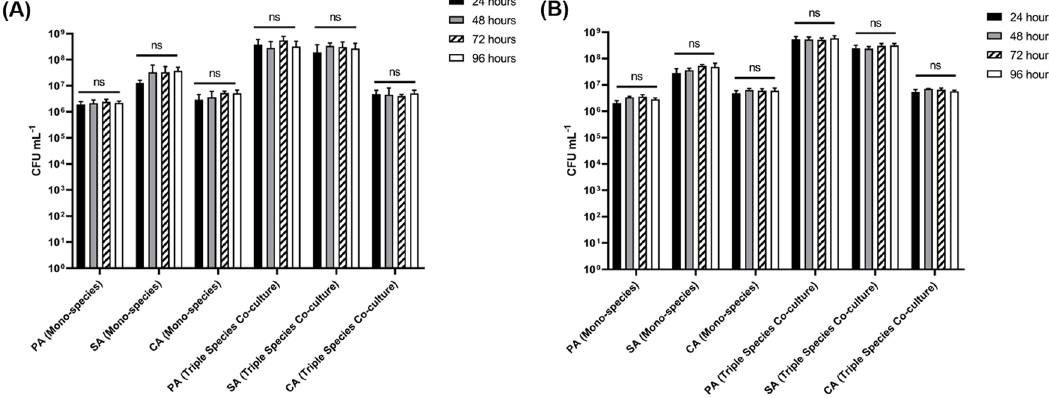
Figure 7. Cell titres of planktonic cultures. P. aeruginosa PAO1 (PA), S. aureus 25923 (SA) and C. albicans SC5314 (CA) cell counts (expressed as CFU mL (cid:3) 1 ) in the planktonic fraction of single-species and polymicrobial cultures incubated in ASM in the continuous-flow model containing (A) agar chunks or (B) ex vivo porcine lung tissue sections as the solid substrata. Data represent the mean (cid:4) standard deviation of two technical replicates collected per timepoint from three independent biological experiments. P > 0.05 is considered as not significantly different